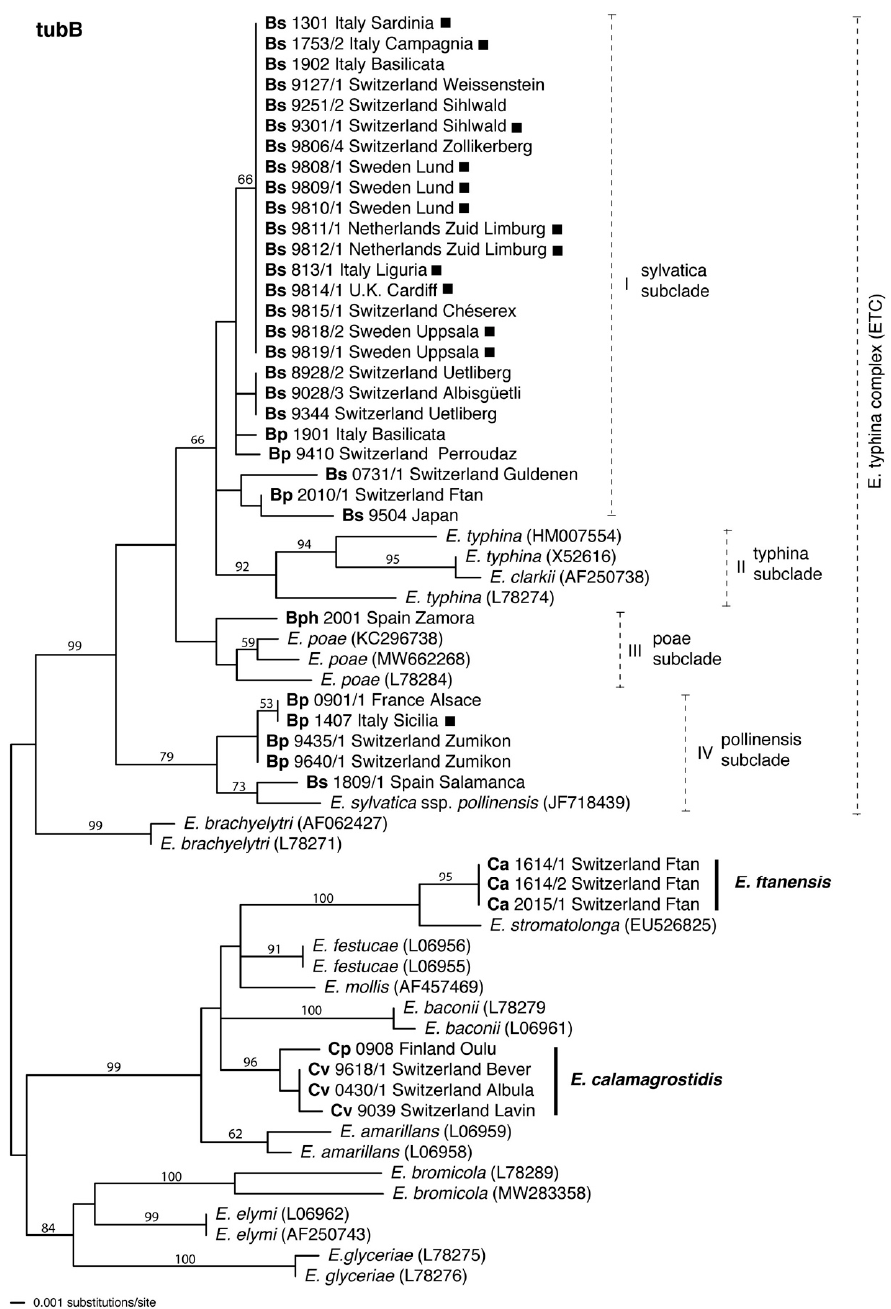
Figure 3. Phylogenetic tree inferred from maximum likelihood (ML) analysis of partial tubB gene sequences including introns 1–3 of Epichloë isolates obtained from Brachypodium and Calamagrostis host grasses: B. sylvaticum (Bs), B. pinnatum (Bp), B. phoenicoides (Bph), C. arundinacea (Ca), C. purpurea (Cp) and C. villosa (Cv). Asexual isolates are indicated with filled squares. representative sequences of all other sexual Epichloë species or subspecies described to date are included. Dashed lines with Roman numerals denote distinct subclades. The tree is midpoint rooted at the left edge. Branch support values were estimated by 100 ML bootstrap replicates and are indicated if above 50%.